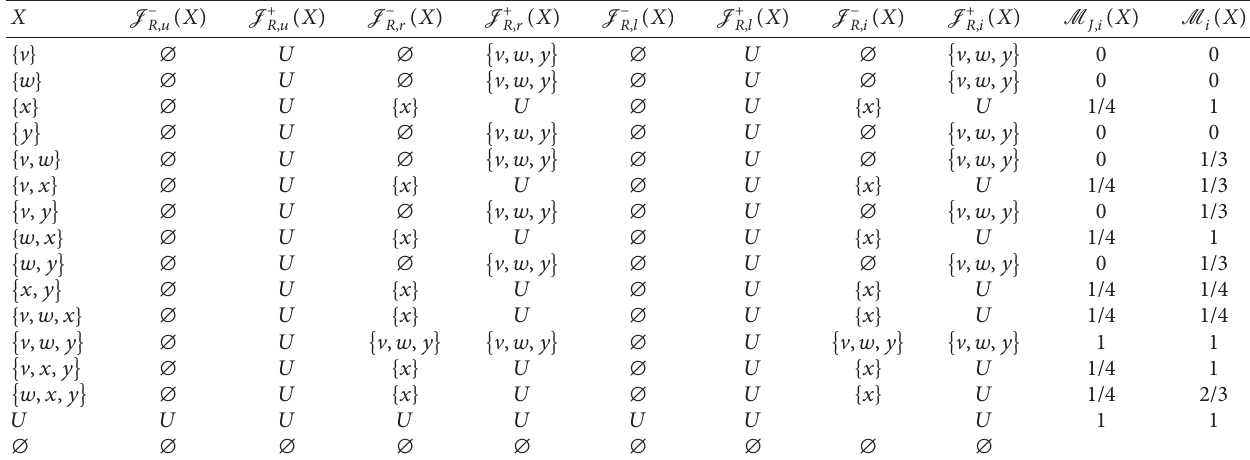
Table 3: J R,j -lower approximations and